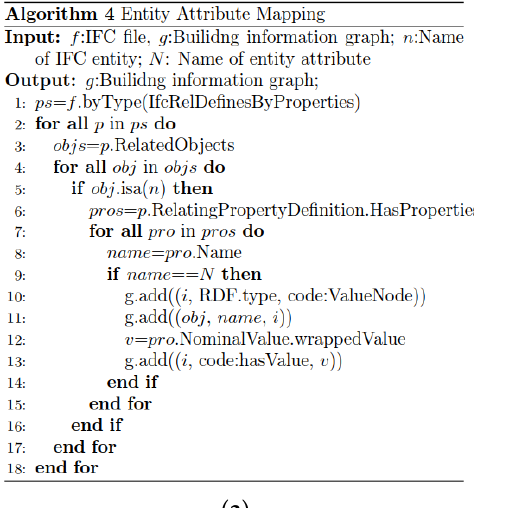
Figure 10. Packaged algorithms of attribute mapping rule development: ( a ) entity attribute mapping rule for the “ IfcPropertySingleValue ” defined via “ IfcRelDefinesByProperties ” ; ( b ) tag mapping rule.